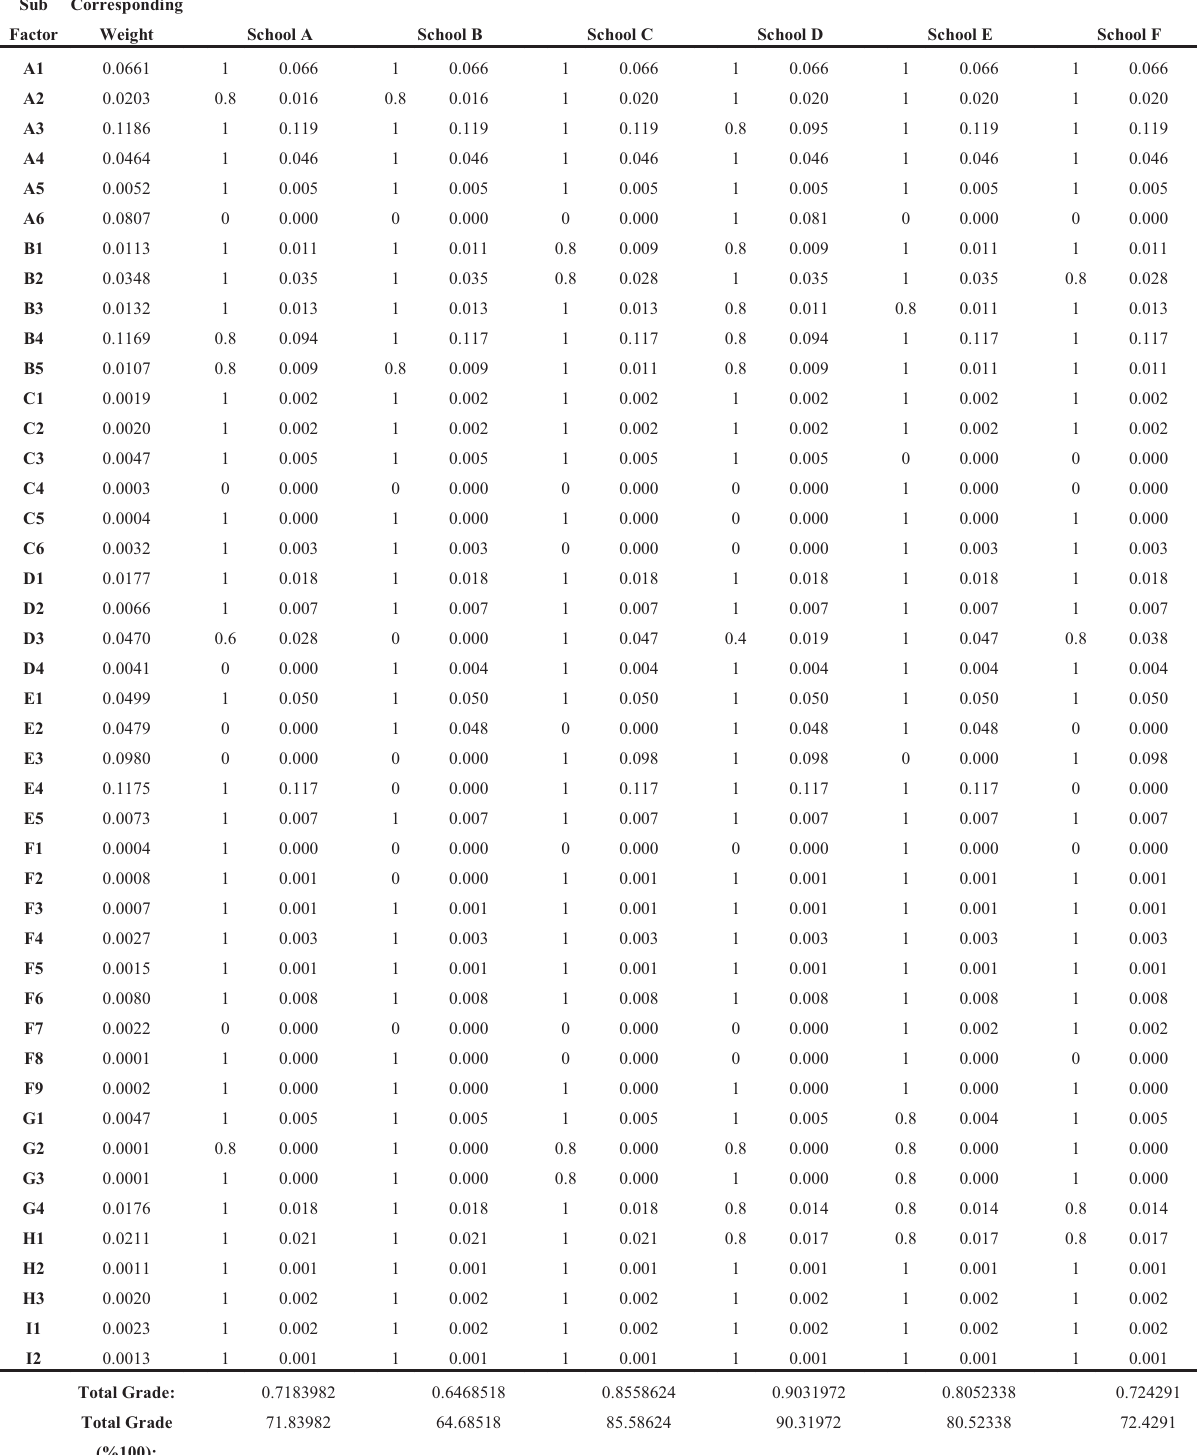
Table 12. Total grades of alternatives based on f ( x ) =